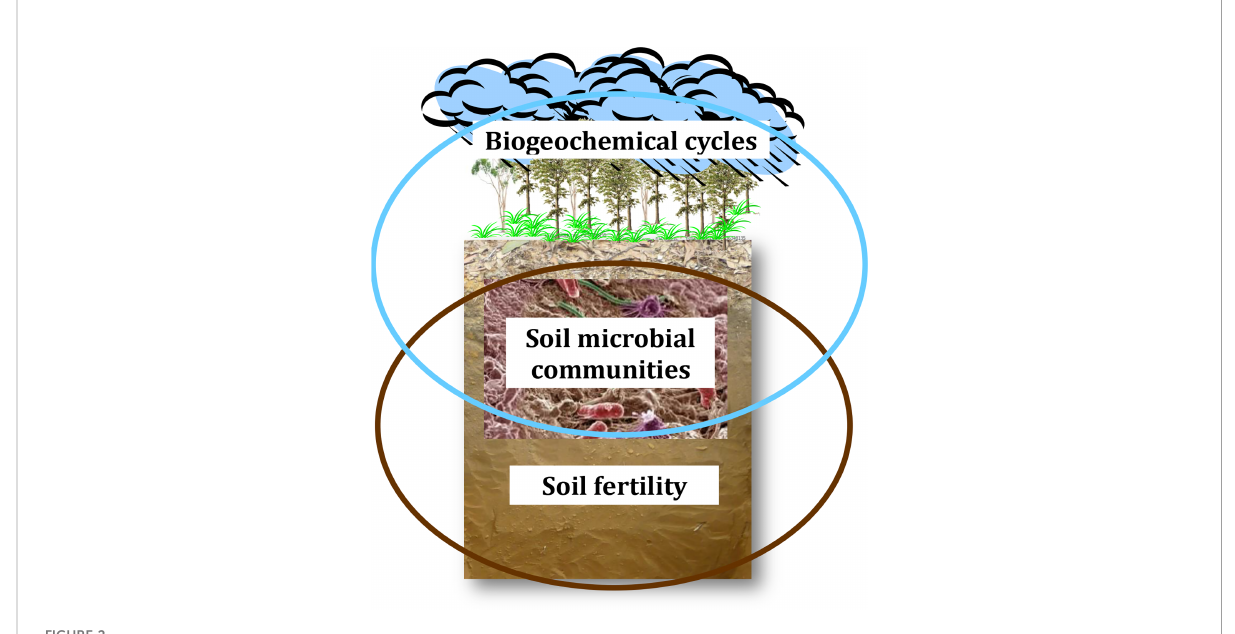
FIGURE 2 Interaction between biogeochemical cycles, soil fertility, and soil microbial